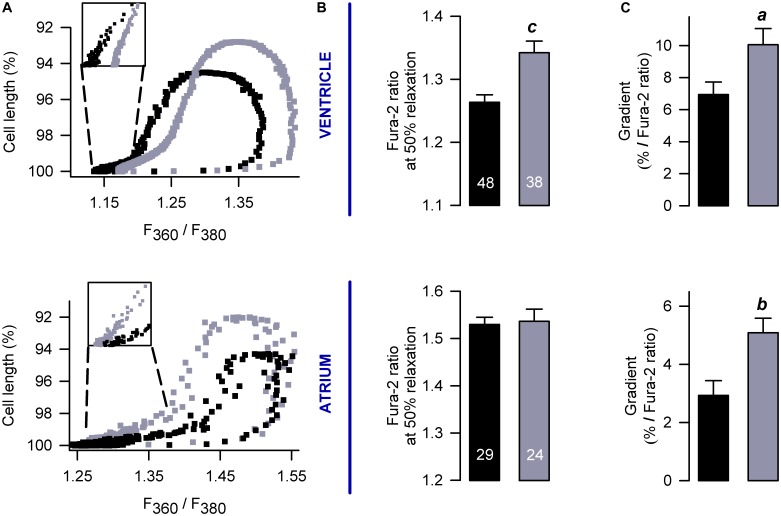
Effects on myofilament Ca2+ sensitivity. (A) Examples of phase plane diagrams of cell length versus ratio of fluorescence of Fura-2 that were used to analyze myofilament Ca2+ sensitivity. Inserts illustrate regions used to estimate the slope of relaxation (or re-lengthening), which were fixed at 90–95% of relaxation. (B,C) Average values of Ca2+ levels required for 50% of relaxation (B) and gradients obtained after fitting endpoint relaxation regions to a straight line (A, inserts). The number of investigated cells is shown in (B). ap < 0.05, bp < 0.005, cp < 0.001.